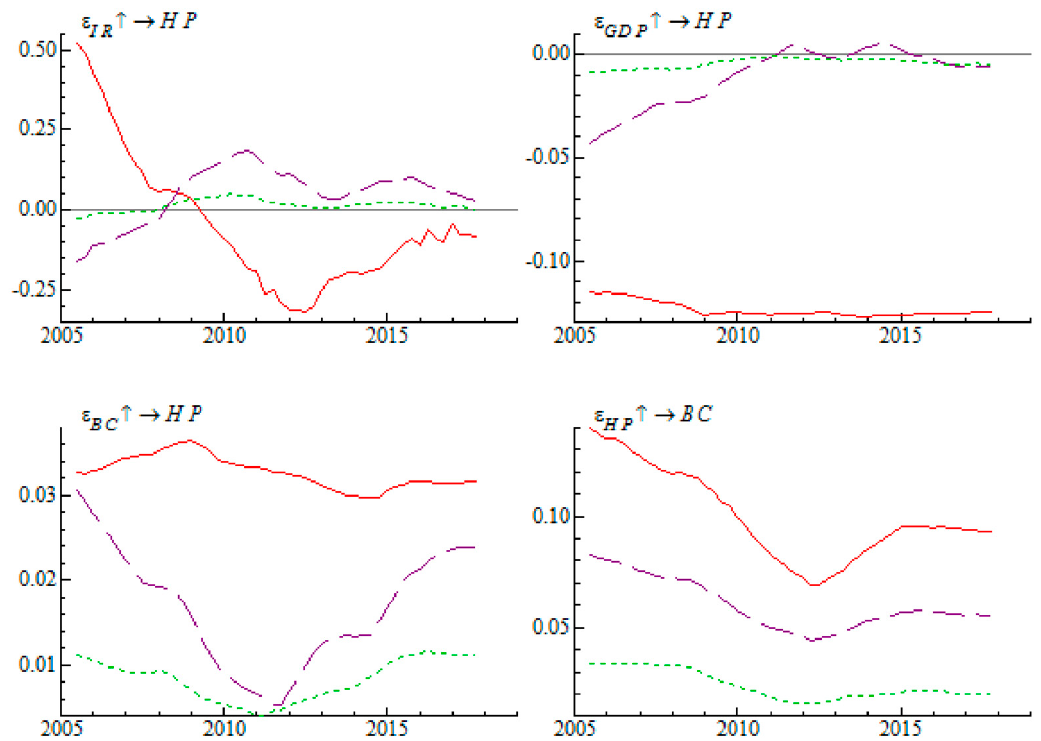
Figure 5. Impulse response for three different horizons. Notes: This shows the impulse response of the TVP-VAR model for the variable set of (IR, GDP, BC, HP); HP represents housing prices, BC represents bank credit, and IR represents the interest rate; the solid line refers to the time-varying impulse responses for each quarter; the dashed line refers to half-year responses; and the dotted line refers to yearly responses.